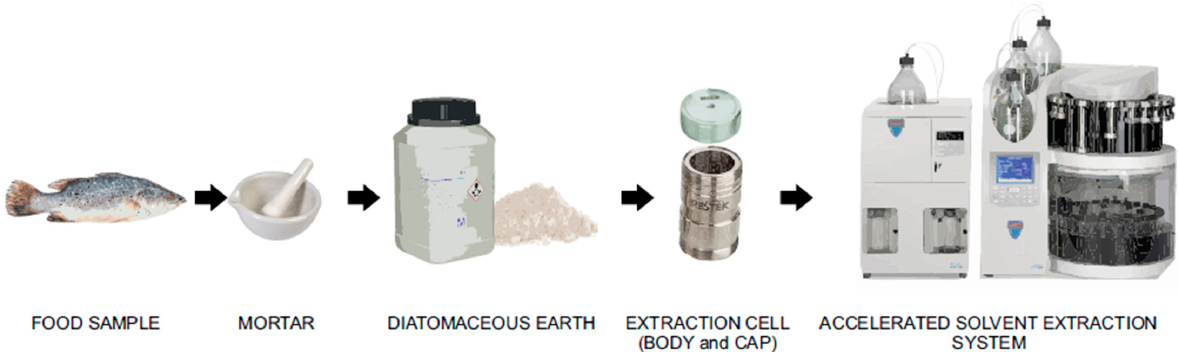
Figure 3. Flowchart of accelerated solvent extraction procedures of animal-derived food samples.